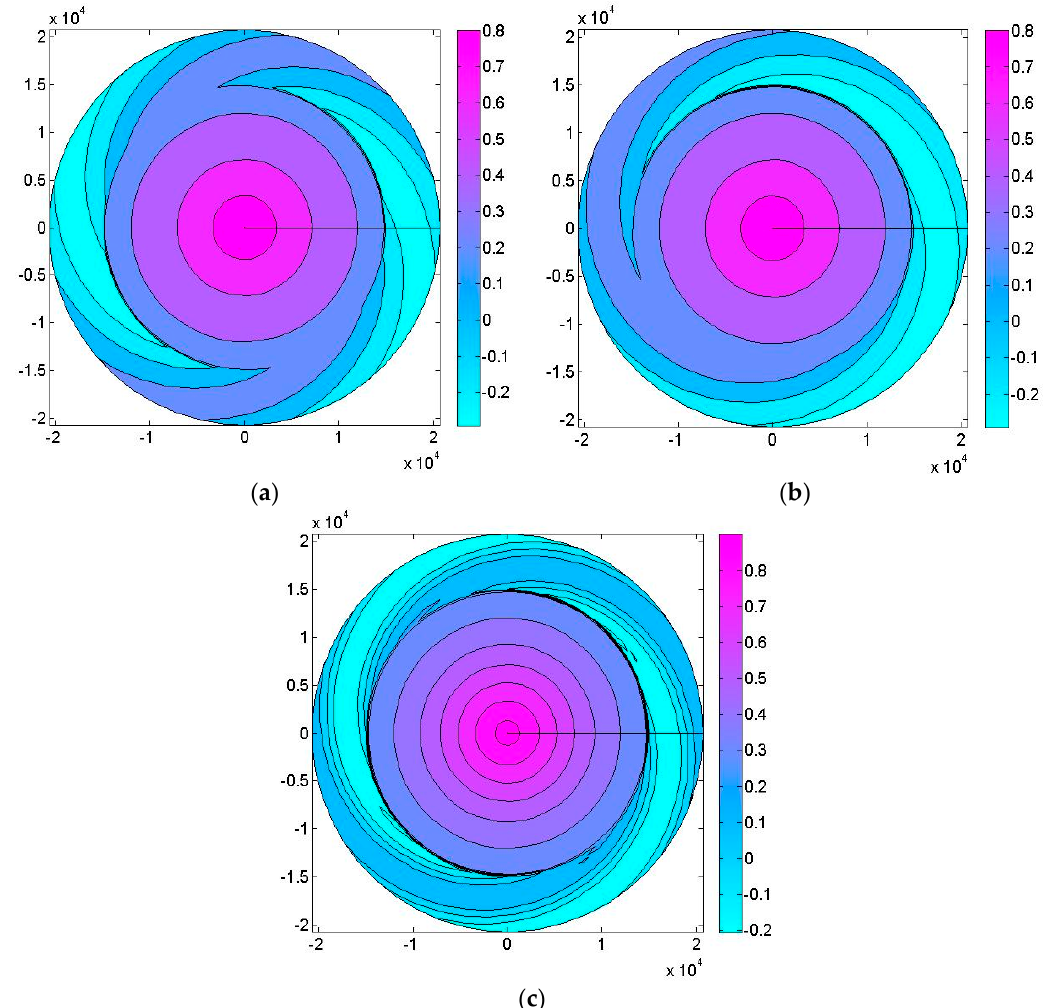
Figure 3. Horizontal structure of theoretical rain clusters with spiral arms. Positive values indicate ascending movement, negative values indicate descending movement. The unit of the coordinate X axis and Y axis is 10 km. The unit of the color bar is m·s − 1 . ( a ) m = 2, k = 1 km − 1 and R = 20 km; ( b ) m = 1, k = 1 km − 1 and R = 20 km; and ( c ) m = 2, k = 2 km − 1 and R = 20 km.